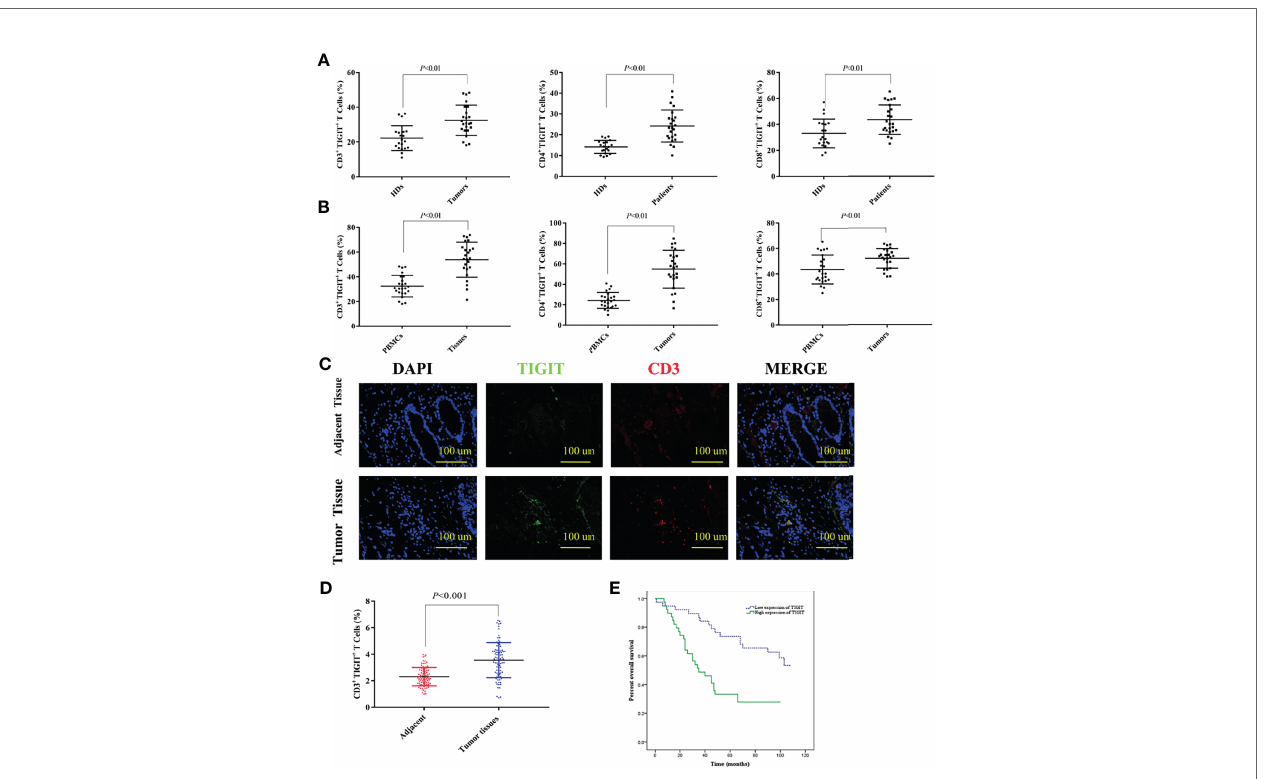
FIGURE 1 | Upregulated TIGIT expression in patients with colorectal cancer predicts poor prognosis. (A) Percentage of CD3 + TIGIT + T, CD4 + TIGIT + T and CD8 + TIGIT + T cells in PBMCs of HDs and colorectal cancer patients. (B) Percentage of CD3 + TIGIT + T, CD4 + TIGIT + T and CD8 + TIGIT + T cells in PBMCs and tumor tissues of colorectal cancer patients. (C) Double fl uorescence staining of colorectal cancer detecting CD3 + TIGIT + T cells. Immuno fl uorescent staining of TIGIT + cells (in green) and CD3 + cells (in red). The merged picture indicated double-positive cells located in the stroma. The image was shown in original magni fi cation of 200×. (D) The quantitative analysis of CD3 + TIGIT + T cell in tissue microarrays. (E) Kaplan-Meier curve for an independent set of 77 colorectal patients ( P <